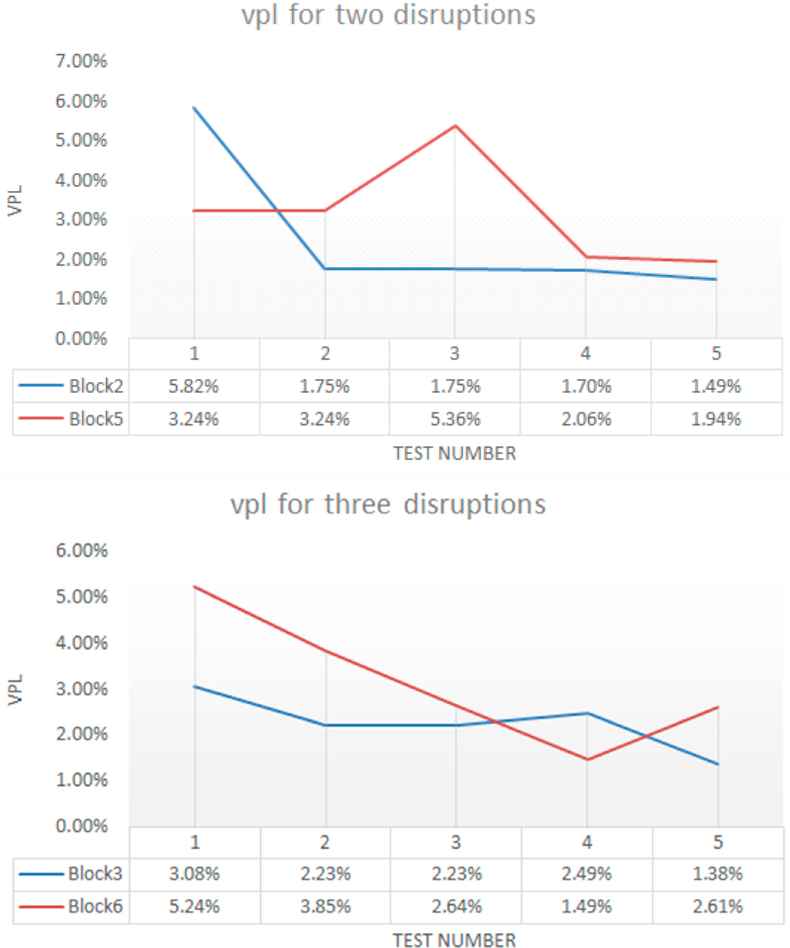
Figure 16. Values of vpl for one, two and three disruptions in the WTerm1 and WTerm2.